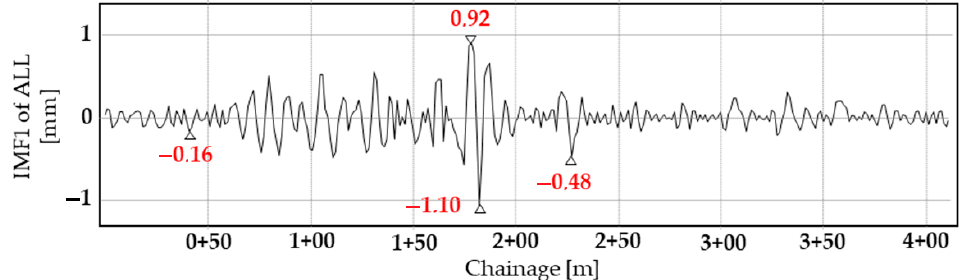
Figure 10. Sample section of EMD generated first IMF of ALL with short-wave and medium-wave irregularities of different extents, inherent mode mixing (track section No. 4).